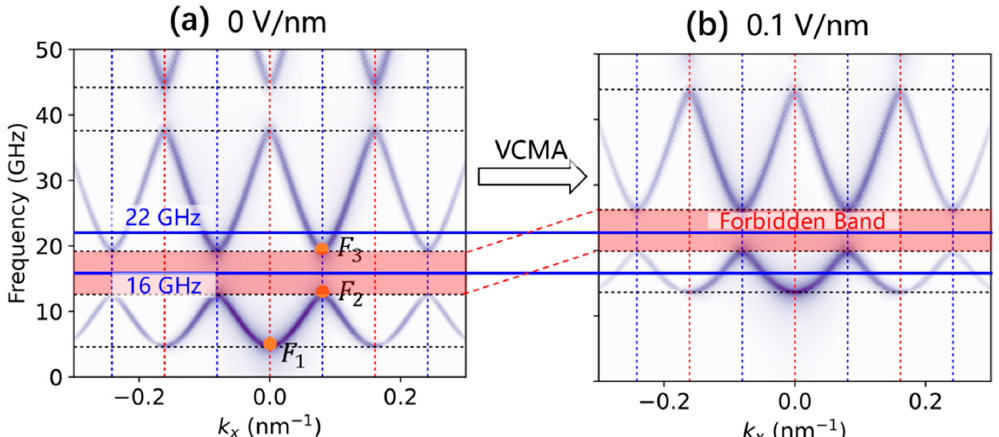
Figure 2. ( a ) Dispersion curves of the spin-wave excitations in the width-modulated nanostrip magnonic crystals. The dispersion curves were calculated using a 2D discrete Fourier transform for the temporal and spatial data at the wire center ( y = 15 nm), which were collected every 1 ps after applying an external magnetic field. Lower and higher band gaps of ∆ l = 12.6–19.2 GHz and ∆ h = 37.6–44.2 GHz were observed due to the periodic width modulations. ( b ) The corresponding dispersion curves when applying an electric field of E = 0.1 V/nm. Due to the VCMA-induced anisotropy, the band gaps changed to ∆ l = 19.9–26.2 GHz and ∆ h = 44.6–51.2 GHz. The forbidden band gap is filled in pink. Selected typical frequencies of 16 GHz and 22 GHz are labelled using blue lines to guide the eyes.